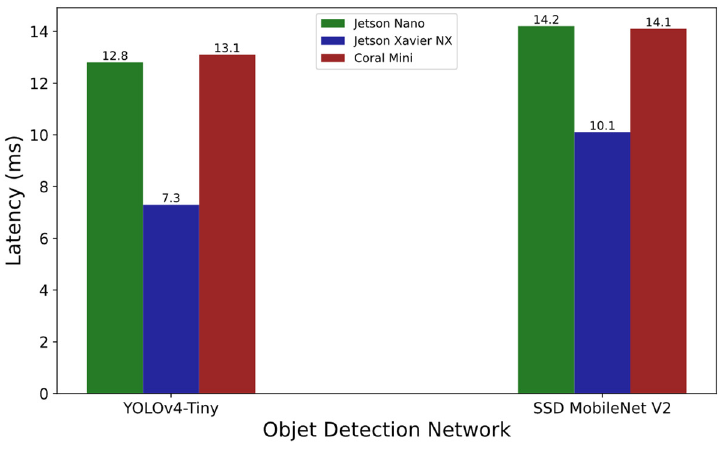
Figure 5. Latency Measurement Results of the Devices.